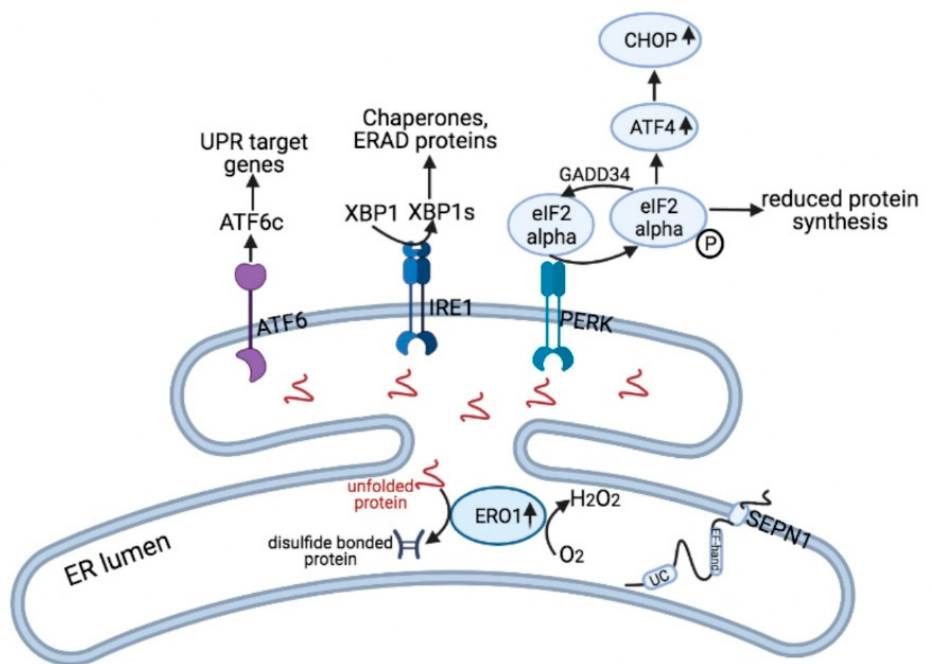
Figure 3. SEPN1 and ER stress. Unfolded proteins trigger ER stress and the consequent UPR by the activation of three sensors ATF6, IRE1 and PERK. Generally, this is a homeostatic response that restores ER homeostasis. After being proteolytically cleaved in the Golgi, ATF6 works as a